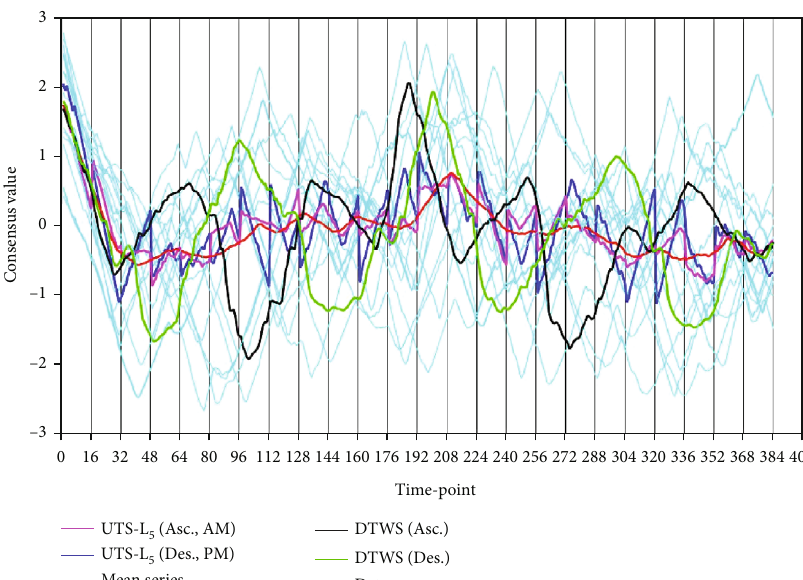
Figure 8: UTS- L : descending hierarchy with PM-inverse (Des., PM) and ascending hierarchy with AM-inverse (Asc., AM). Data track: 5 OSULeaf data.